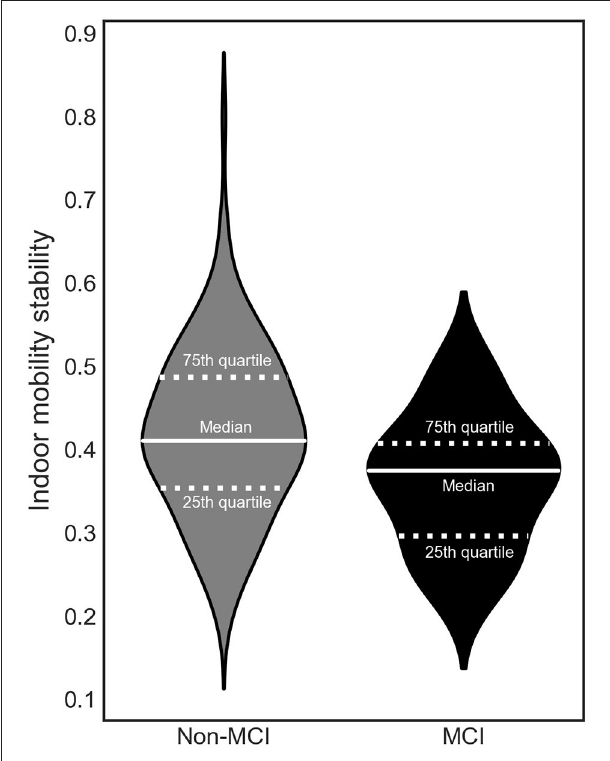
FIGURE 3 | The relationship between indoor mobility stability and mild cognitive impairment (MCI).